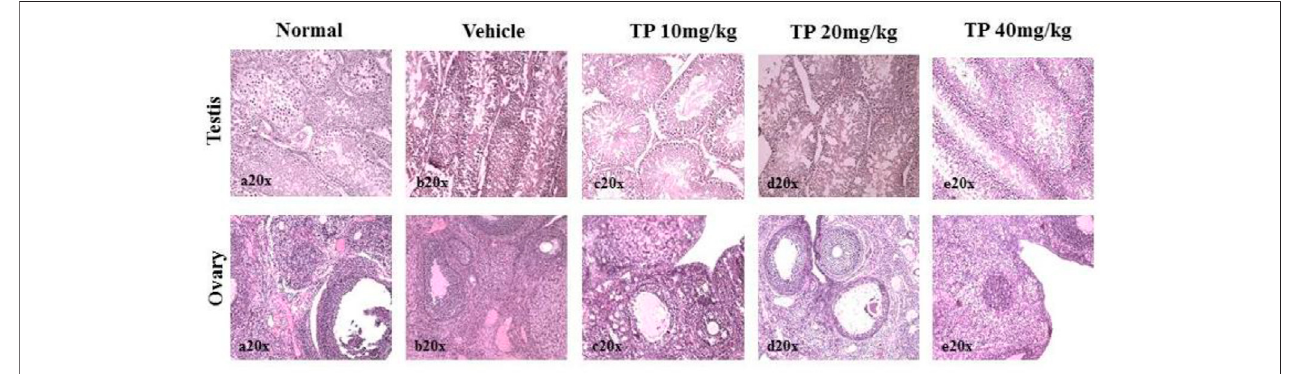
FIGURE 15 | Histopathological analysis of sex organs showing normal architecture in the male and female SD rats after 28-day treatment of Thamira Parpam.